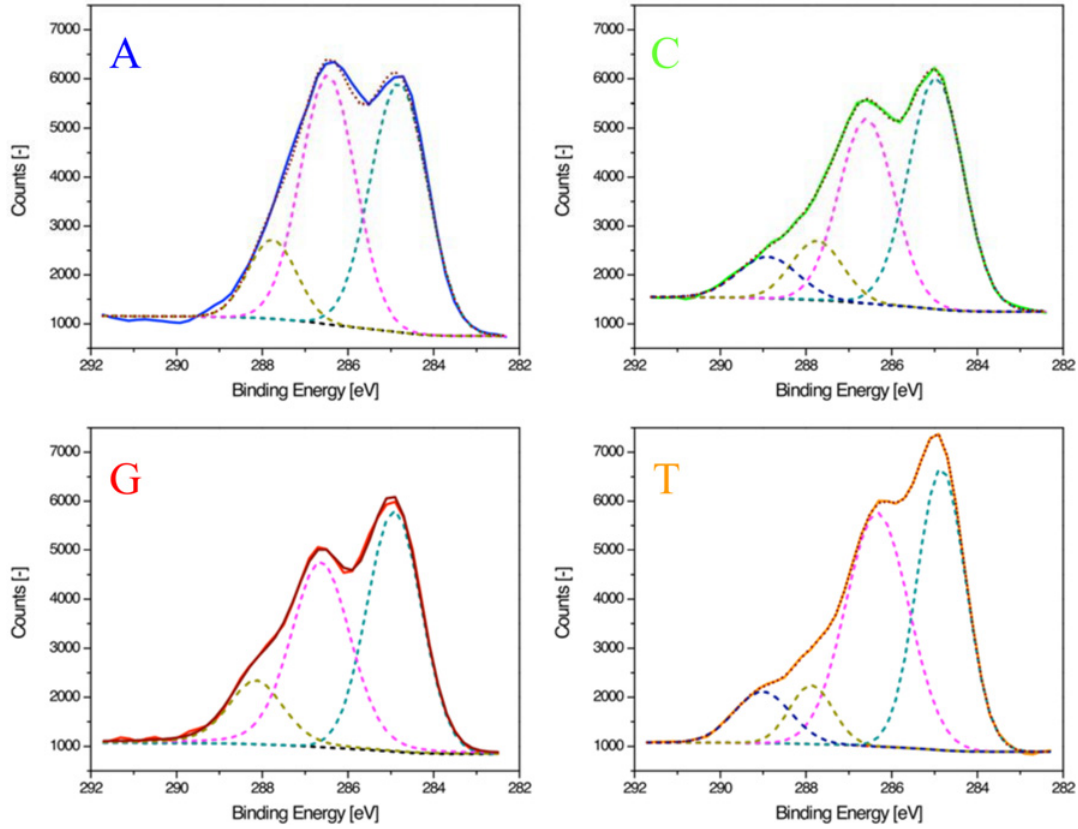
Fig 5. High-resolution carbon 1s XPS spectra for single-stranded homopolymeric